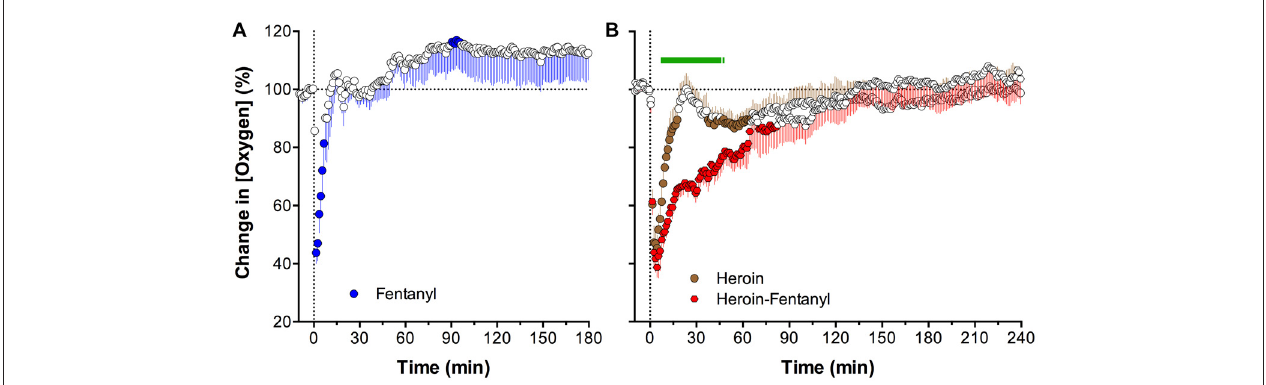
FIGURE 8 | Mean ( ± SEM) changes in NAc oxygen levels induced by intravenous injections of fentanyl ( A ; 0.04 mg/kg), heroin ( B ; 0.4 mg/kg) and heroin laced with 10% fentanyl ( B ; 0.36 + 0.04 mg/kg, respectively). Values significantly different from baseline are shown as filled symbols. Green line in (B) shows time interval for which differences in changes between groups were significant. Vertical dotted lines show onsets of injections. Data were analyzed with slow, 1-min time resolution and they are expressed as a relative change vs. pre-injection baseline. Original data were published in Solis et al. (2017b).